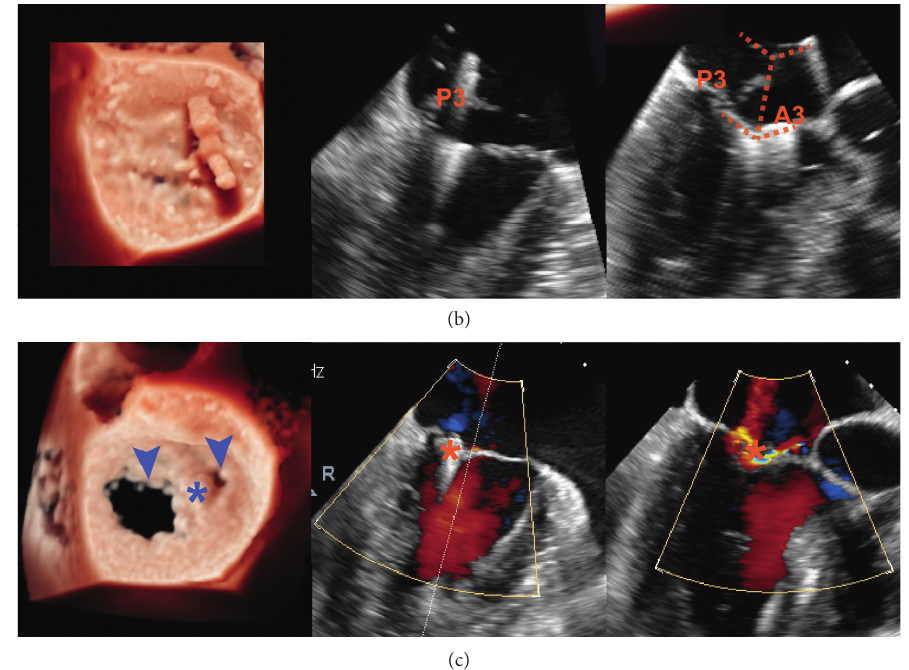
Figure 8: Noncentral ValveClamp implantation and its effect in a patient with a P3 prolapse and flail. Left column: real-time 3D TEE TrueVue mode; middle and right column: ME-commissural view and ME-LAX view of X-plane imaging mode, respectively. (a) X-plane image (systolic frame) helped the operator to identify a proper site of puncture (arrow). (b) The process of leaflet capture using the clamp (orange dotted line). (c) 3D TEE (diastolic frame) demonstrating a large and a small MV orifice (arrowheads) and X-plane image (systolic frame) showing two trivial residual regurgitant jets after clamp release